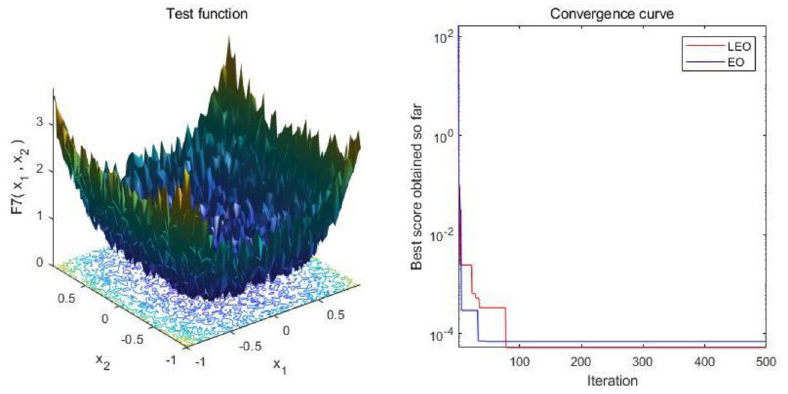
Fig 2. Comparison of convergence curves of LEO and EO algorithms on